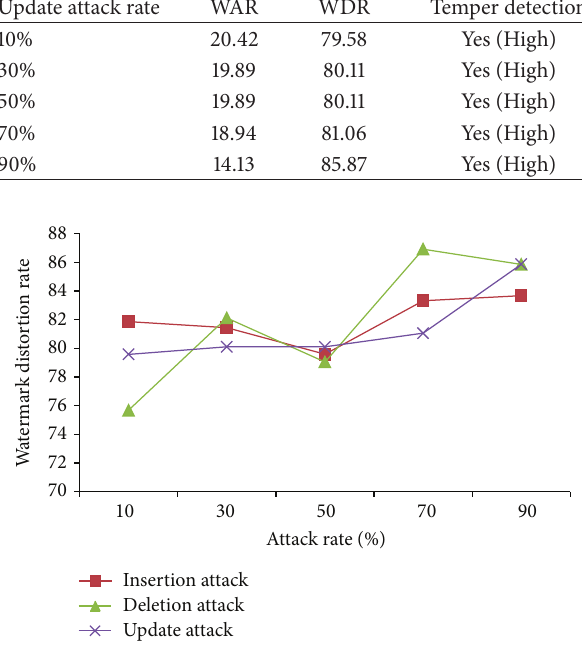
Figure 3: Watermark distortion rate for malicious insertion, dele- tion, and update of tuples with different attack rates (𝑛 = 10 6 )